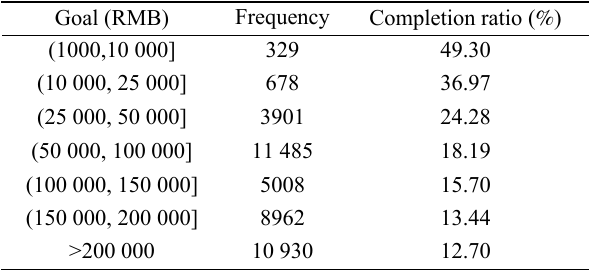
Table 5 Different completion ratios across target